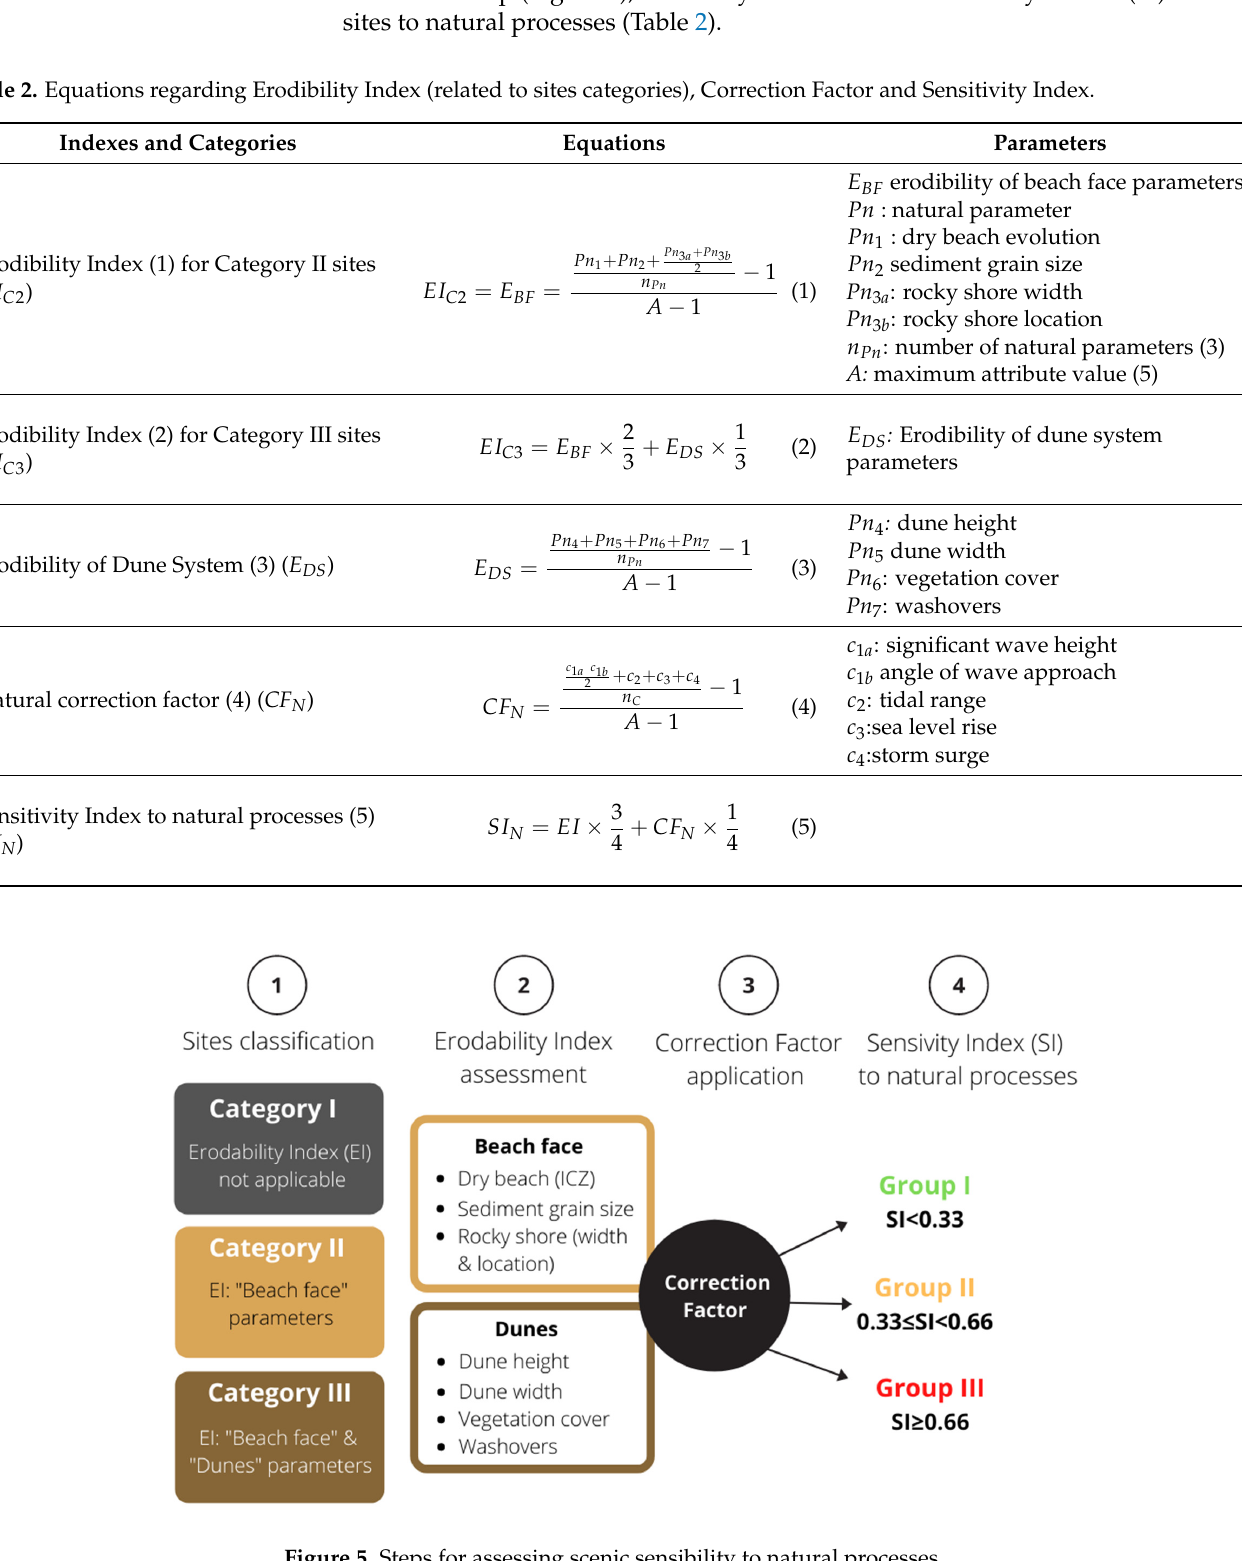
Figure 5. Steps for assessing scenic sensibility to natural processes. Table 2. Equations regarding Erodibility Index (related to sites categories), Correction Factor and Sensitivity Index. Indexes and Categories